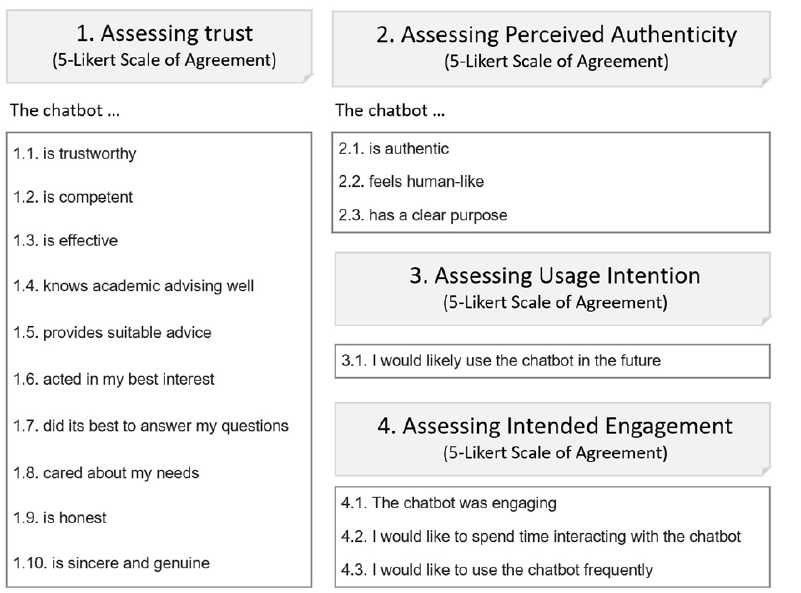
Figure 4. Quantitative assessment of trust, authenticity, usage intention, and engagement.